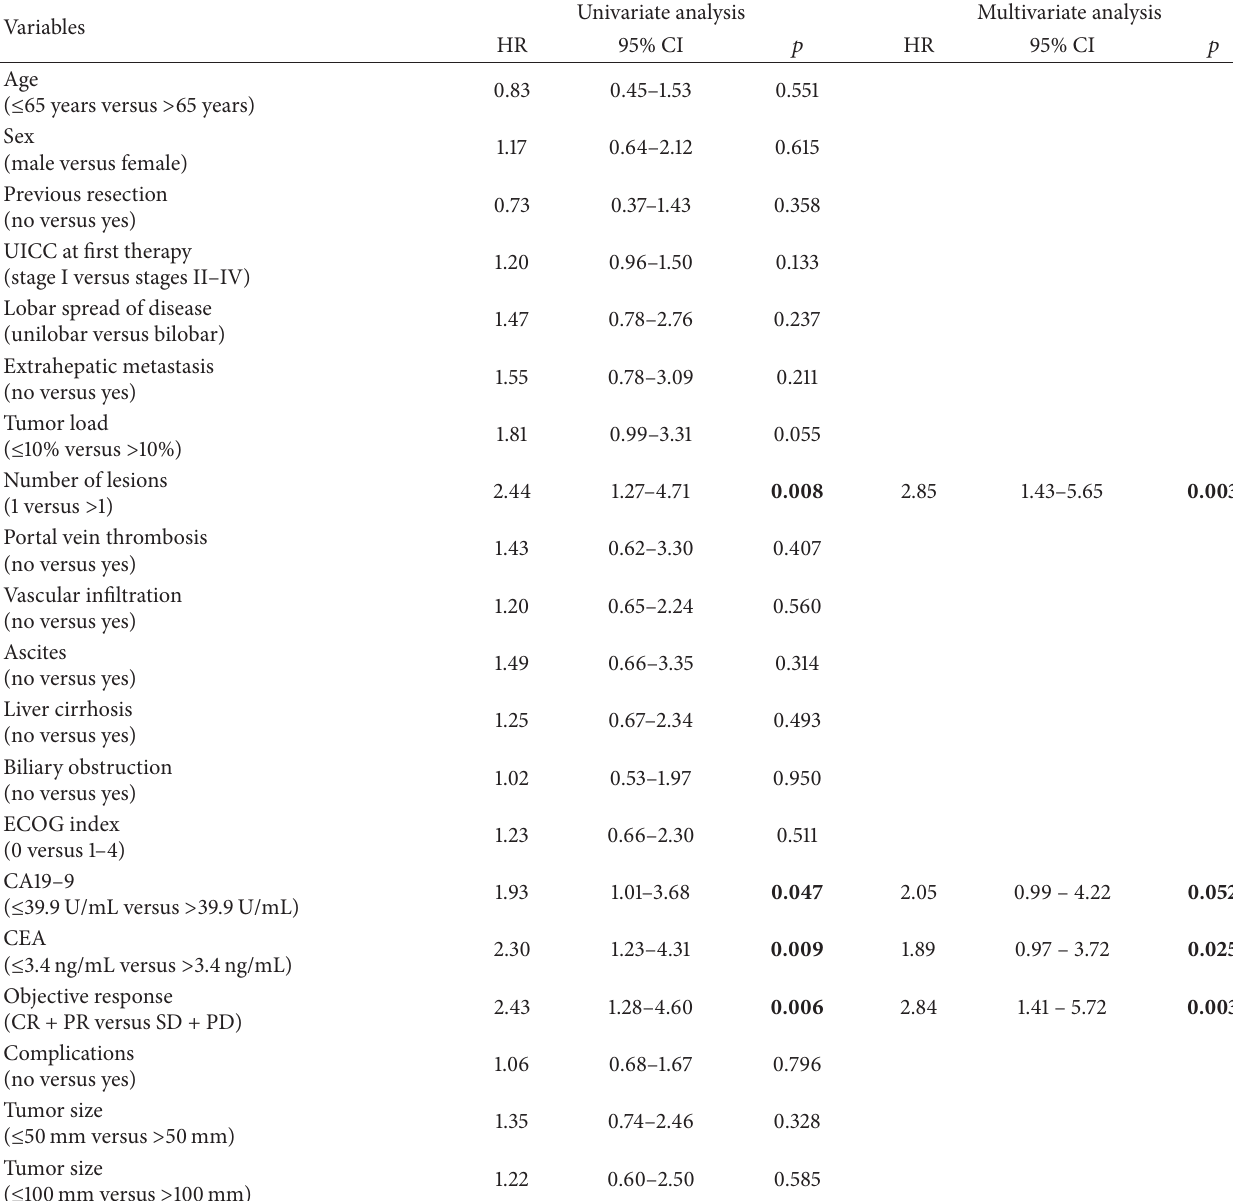
Table 3: Cox regression analysis of the prognostic factors of the patient survival